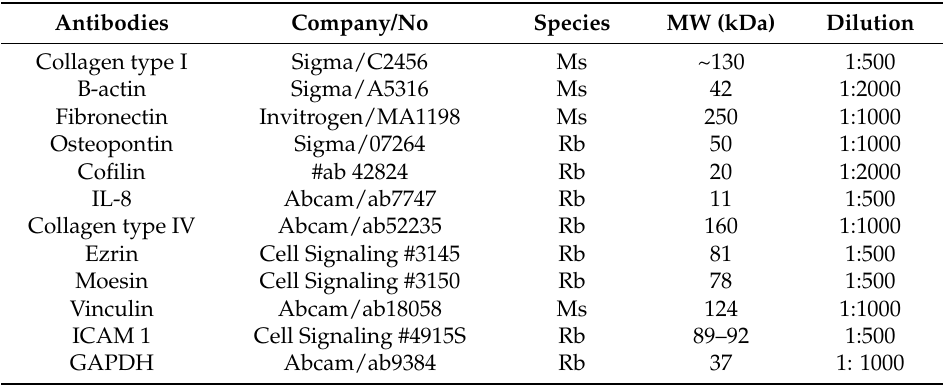
Table 2. Antibodies for Western blot